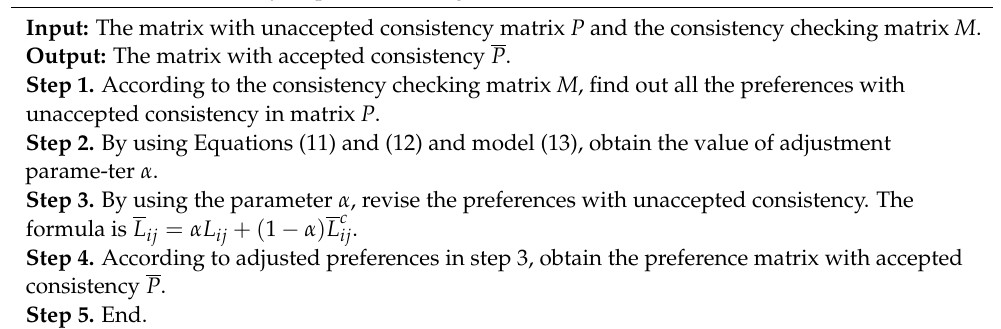
Algorithm 2. Consistency Improvement